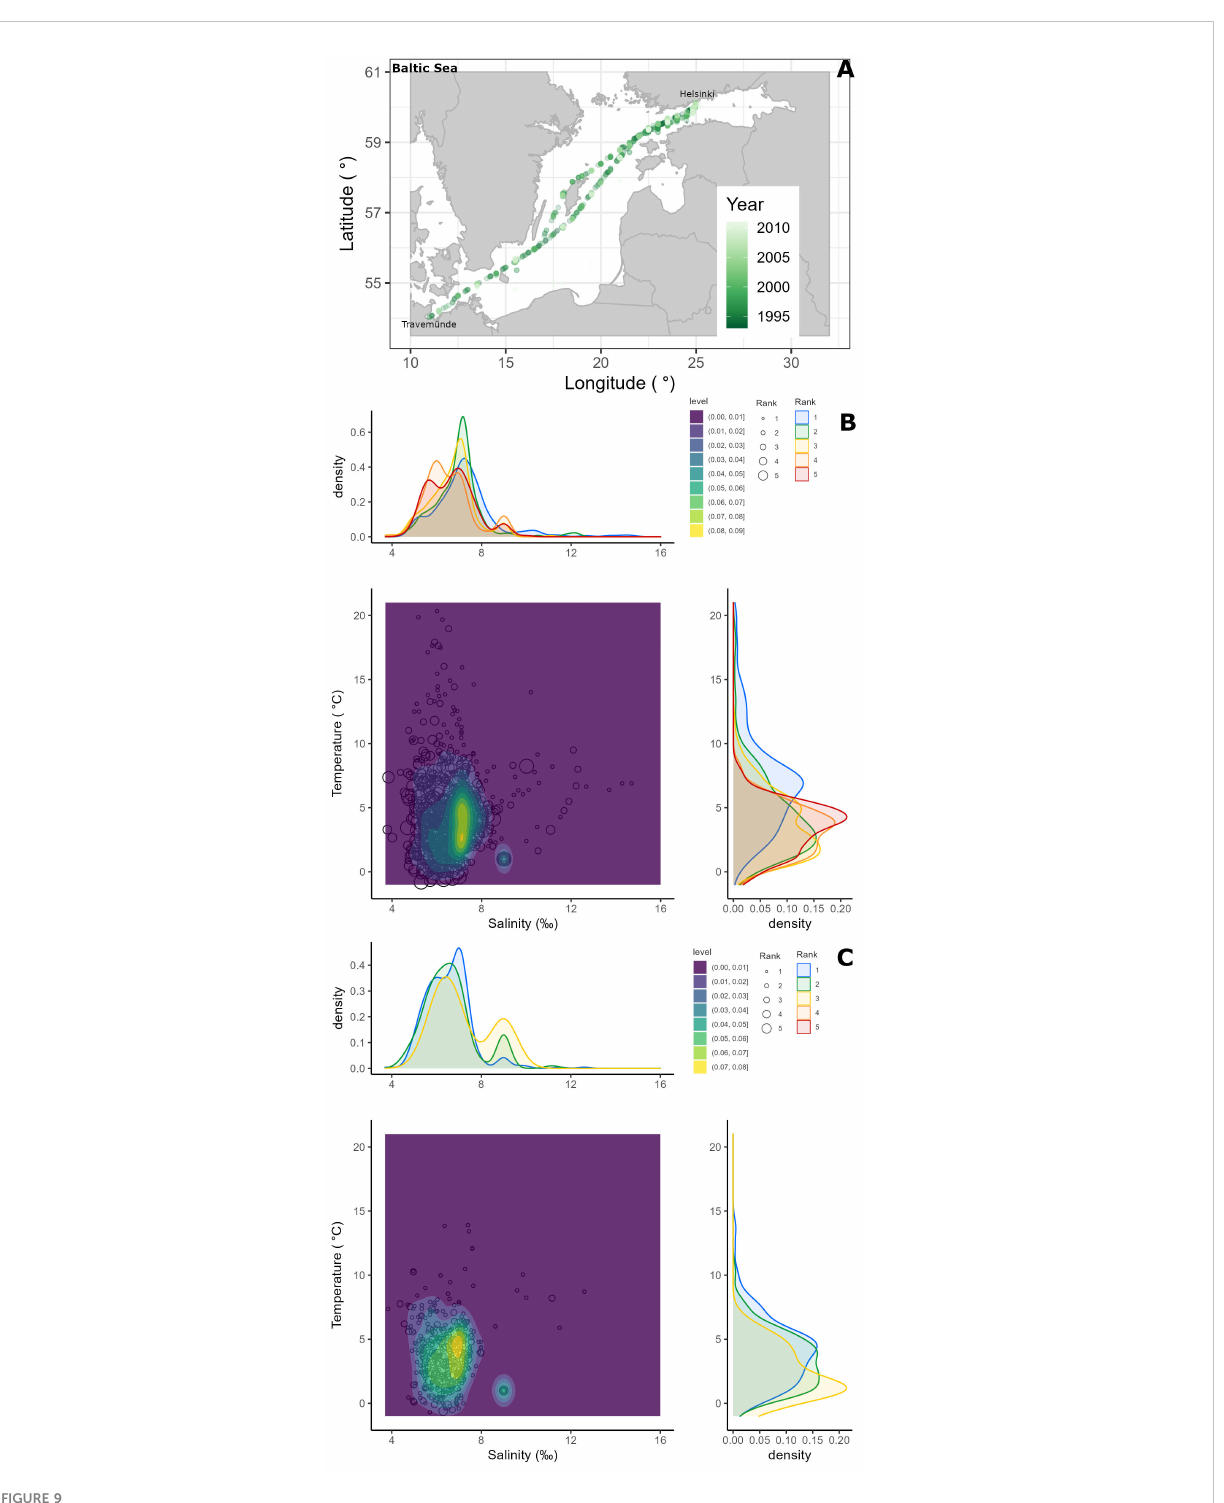
frequently occurred at salinities 6-7 ‰ (kernel density estimate 0.35-0.45) and at 0.5°C (kernel density estimate >0.2), although a shoulder (kernel density estimate 0.1) can be observed at around 5°C (Figure 9C).